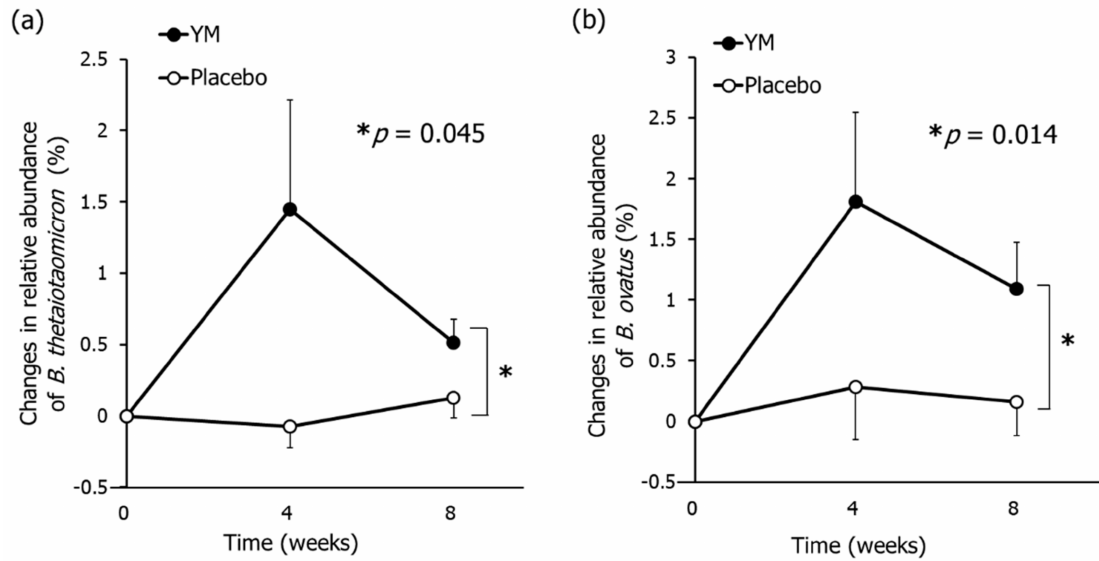
Figure 1. E ff ects of YM intake on the relative abundance of B. thetaiotaomicron and B. ovatus in feces. Changes in relative abundance of B. thetaiotaomicron ( a ) and B. ovatus ( b ). The black circles represent the YM group and the white circles represent the placebo group. Data represent the means ± standard error (SE). The p -values were measured using repeated-measures analysis of variance (ANOVA) for the di ff erences between groups without multiple comparison correction. Asterisks indicate overall significance between groups across time points (* p <